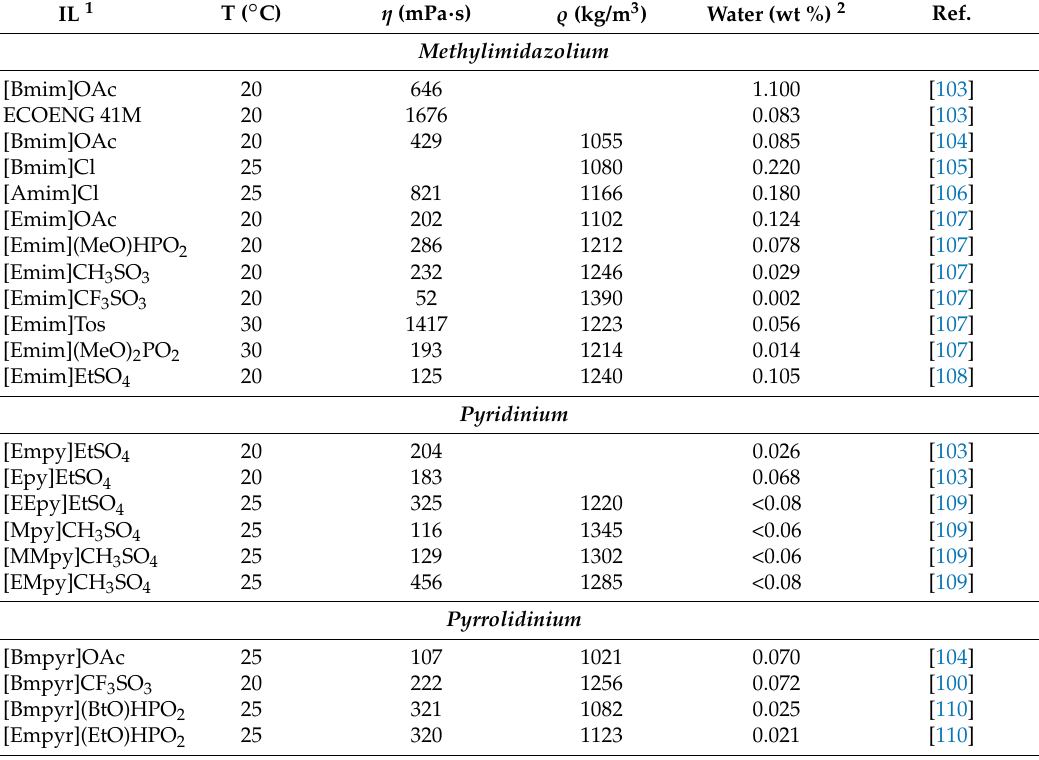
Table 2. Viscosity ( η ), density ( (cid:36) ), and water content (wt %) of